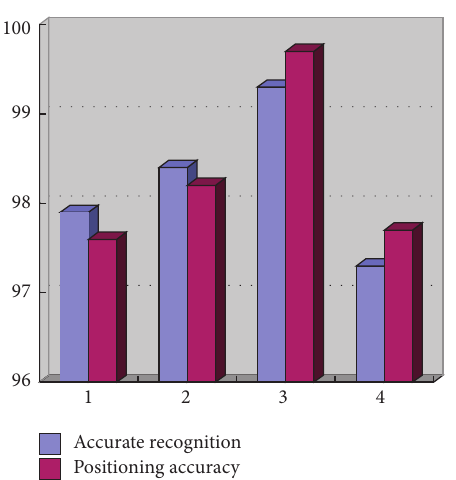
Figure 5: Picking performance test of picking robot (%).